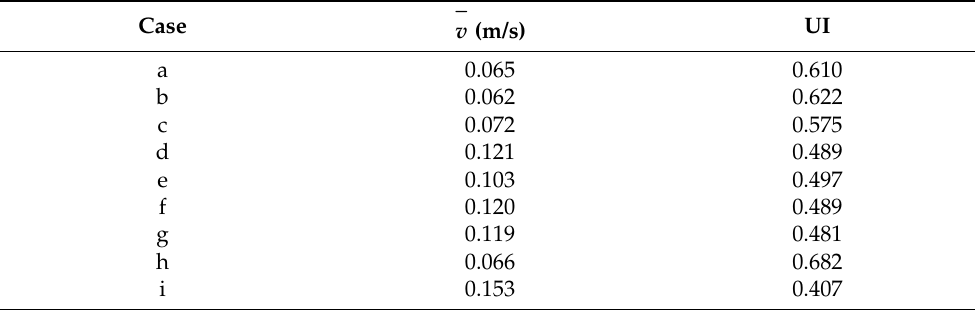
Table 4. Average velocity and uniformity index for velocity.